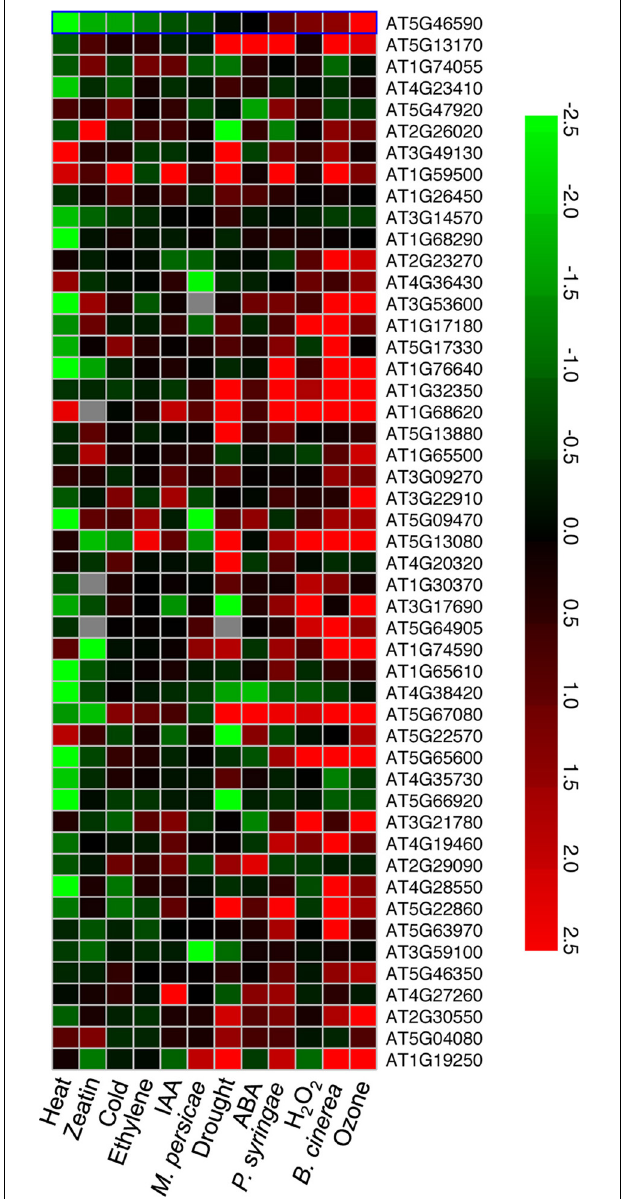
FIGURE 3 | A heat map of expression patterns for the 49 upregulated genes in 48h LT-treated vte2 under other stress conditions. Genes (AGI number) significantly induced in 48h LT-treated vte2 relative to Col plants were examined using the Meta-Analyzer feature of GENEVESTIGATOR to assess their responses to various stress conditions or treatments. The conditions and treatments shown were selected from GENEVESTIGATOR to represent a range of biotic, abiotic, and major hormone treatments and are sorted by increasing ratios from the left to the right. The color bar represents expression levels (log 2 ) relative to each corresponding negative control in